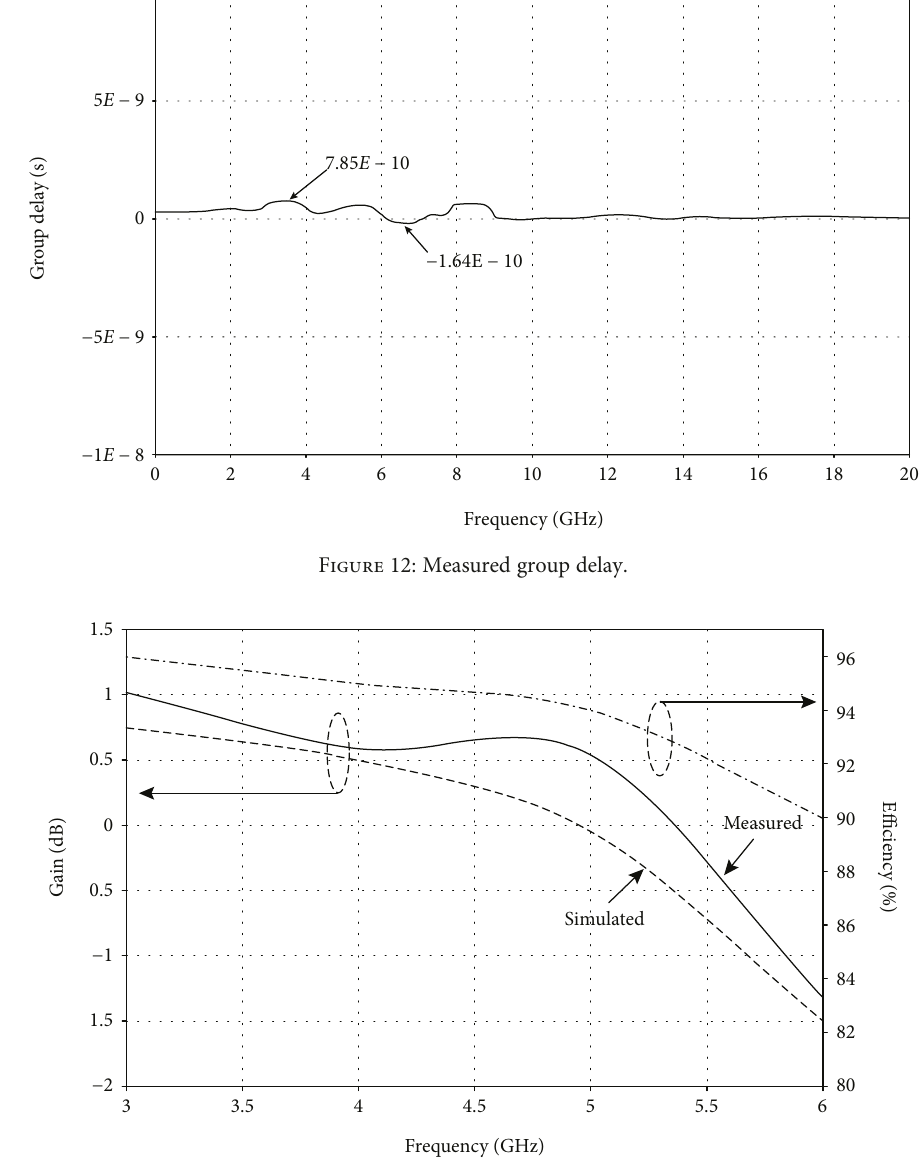
Figure 13: Comparison of simulated and measured peak gain and radiation e ffi ciency. Table 2: Comparison of di ff erent UWB